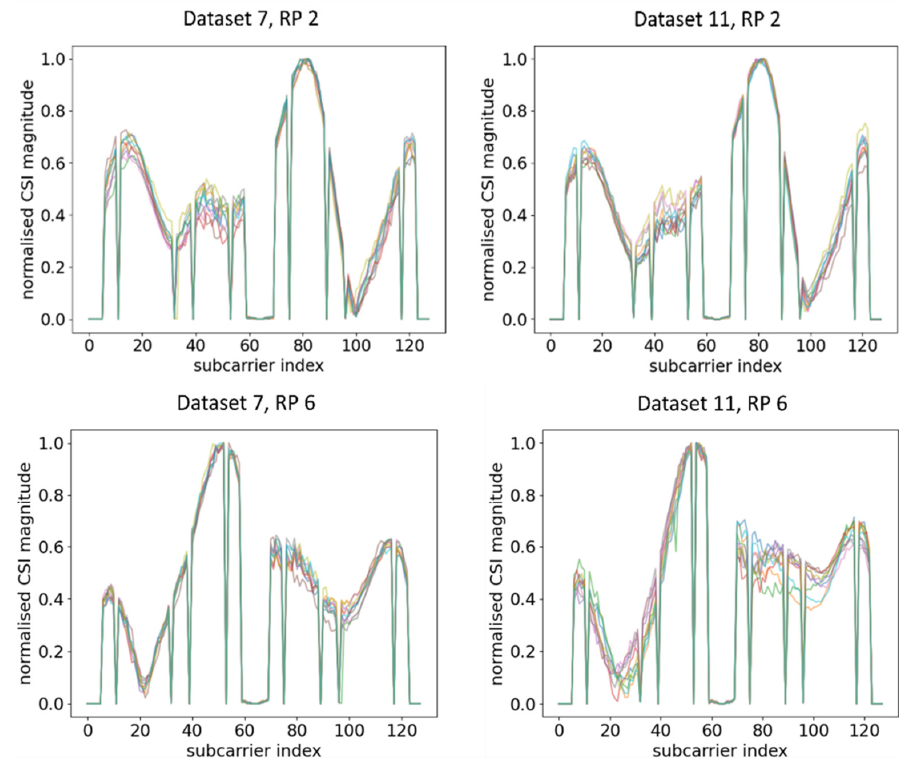
Figure 10. Plots of CSI amplitude in two different time periods at different RPs using AP 2.